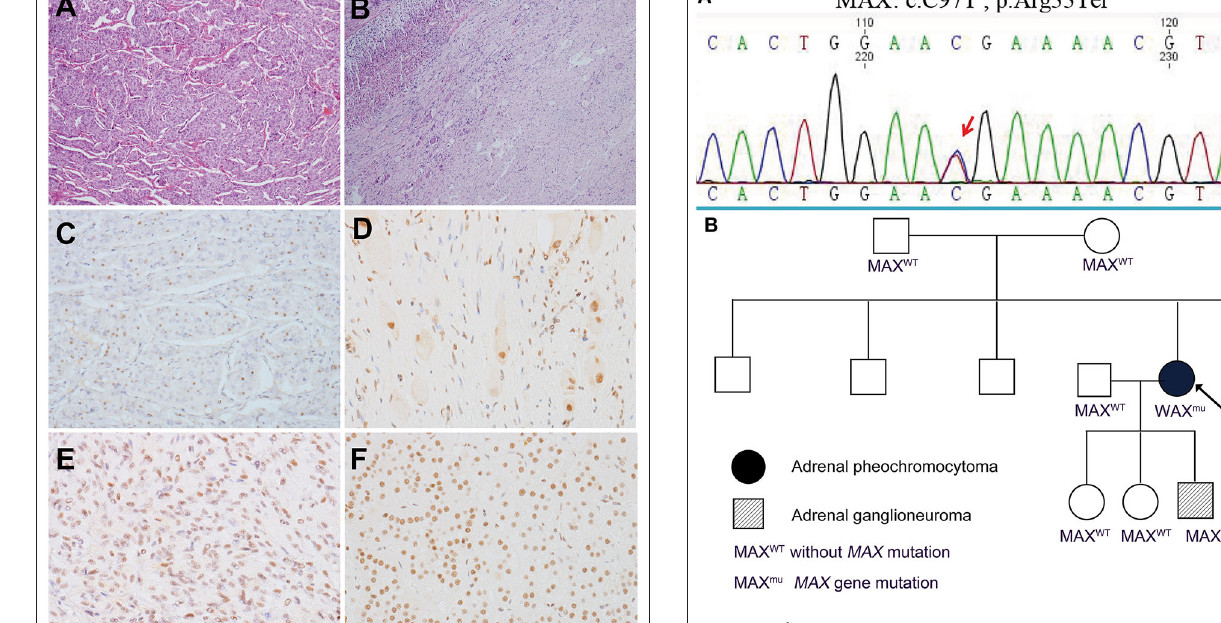
around GN and a PCC carrying RET mutations was used as controls. Only cases showing nuclear staining were considered as valuable. Immunohistochemical detection